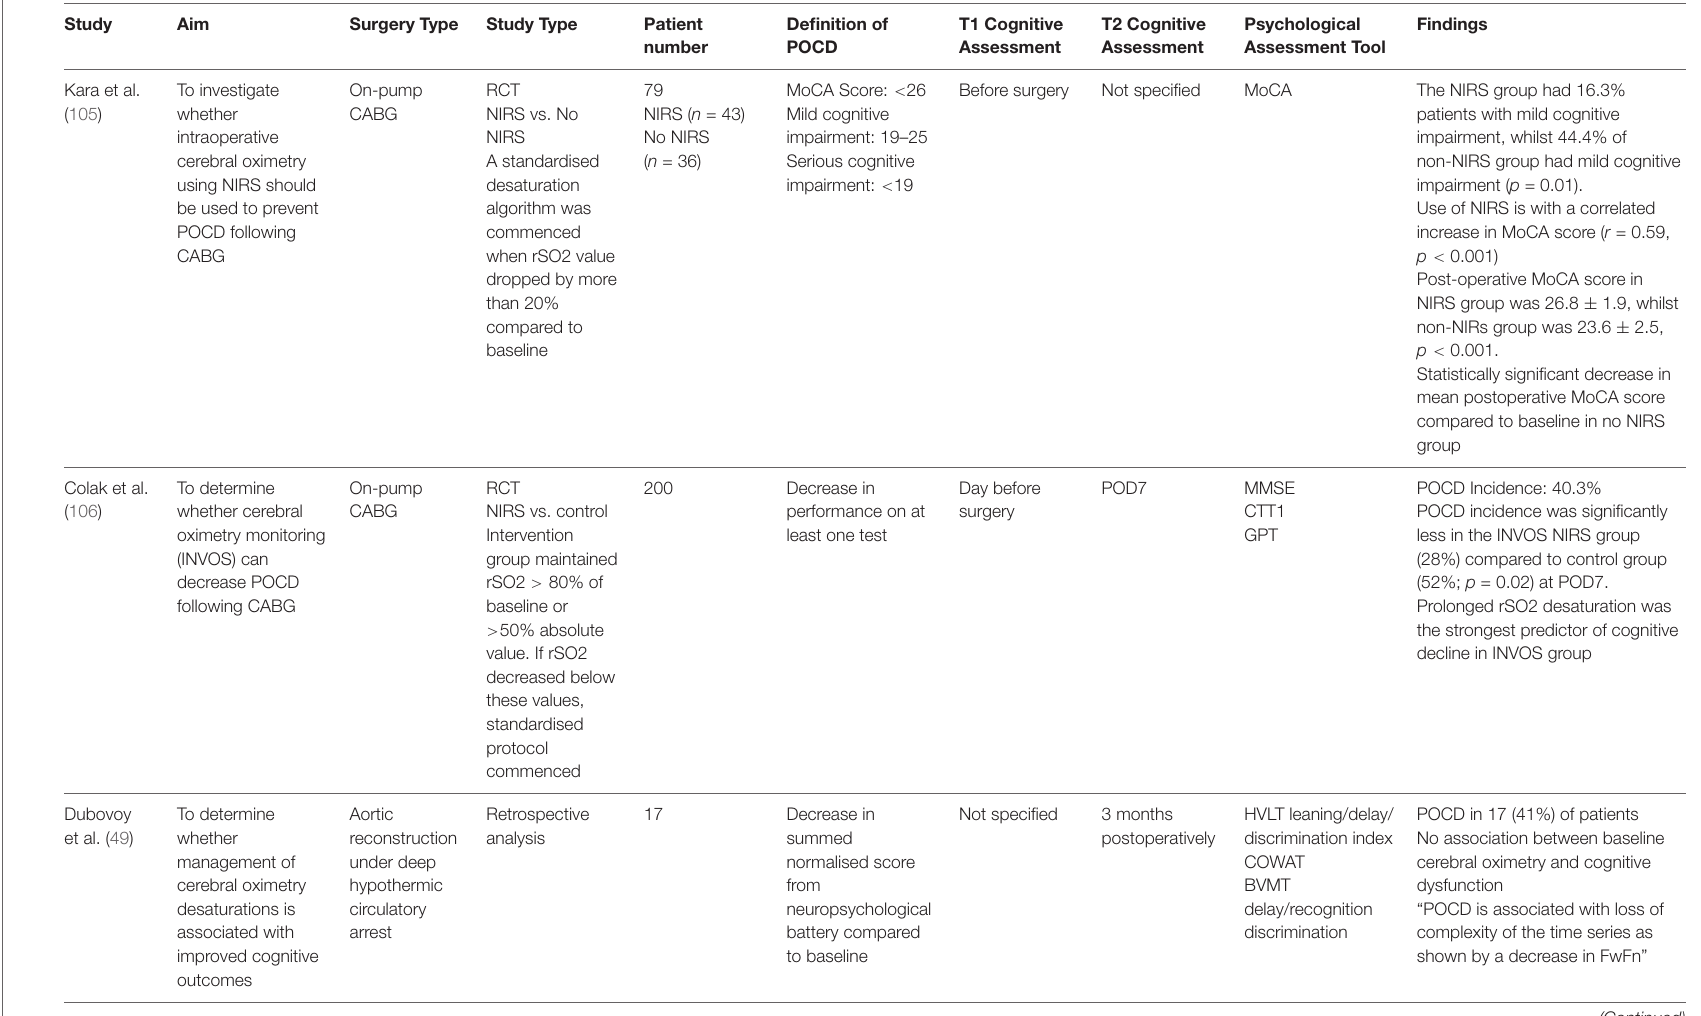
TABLE 4 | Studies examining the efficacy of NIRS to detect cerebral desaturations in preventing POCD following cardiac